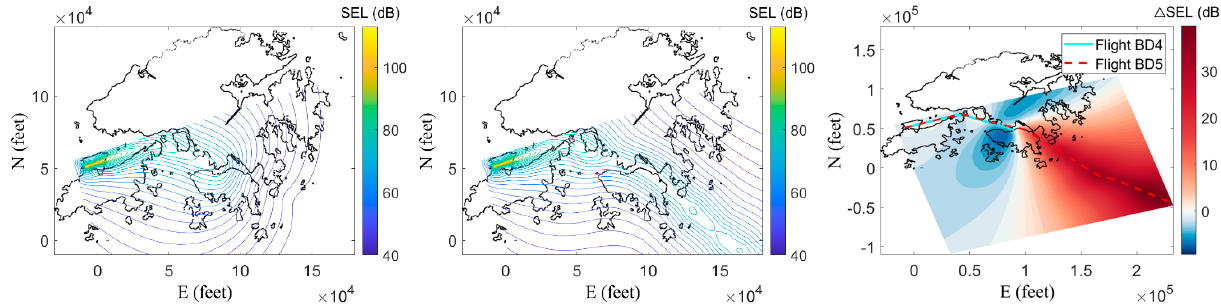
Figure A5. B777 aircraft departing from HKIA. Noise impact (SEL) generated by flight BD4 ( left ) and BD5 ( center ) over Hong Kong city, along with difference ( ∆ SEL) between both results (as obtained by subtracting the former from the latter, right ).